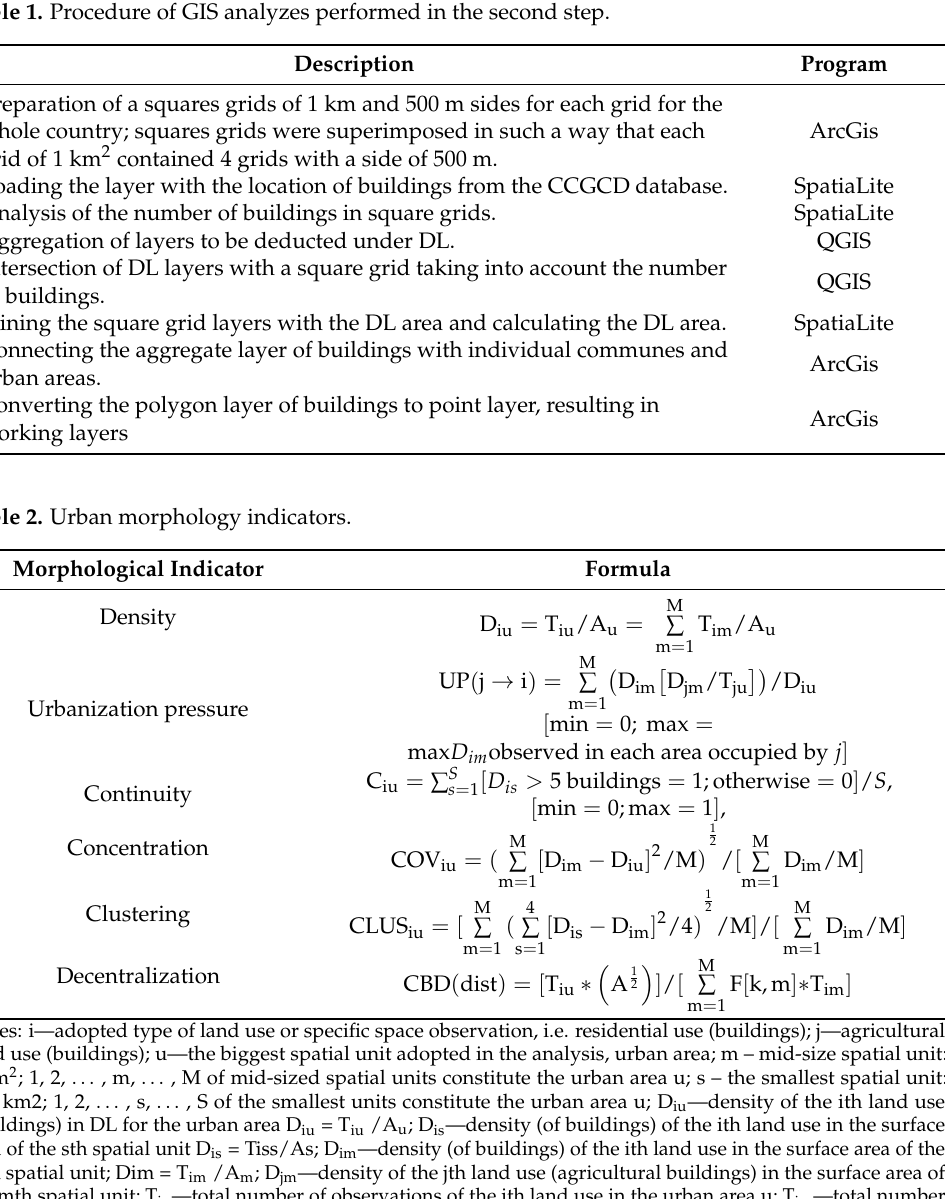
ArcGis QGIS ArcGis ArcGis